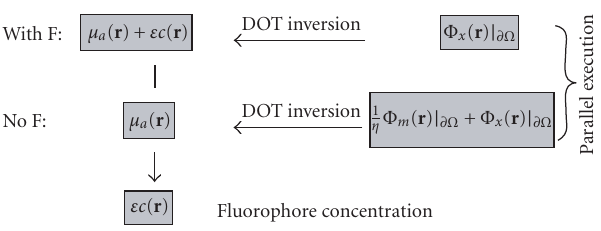
Figure 1: The process of parallel inversion scheme. The two “ F ” at the left are short for “fluorophore.” The reconstruction of fluo- rescence tomography in heterogeneous medium is converted to two parallel absorption coe ffi cient inversed problems in